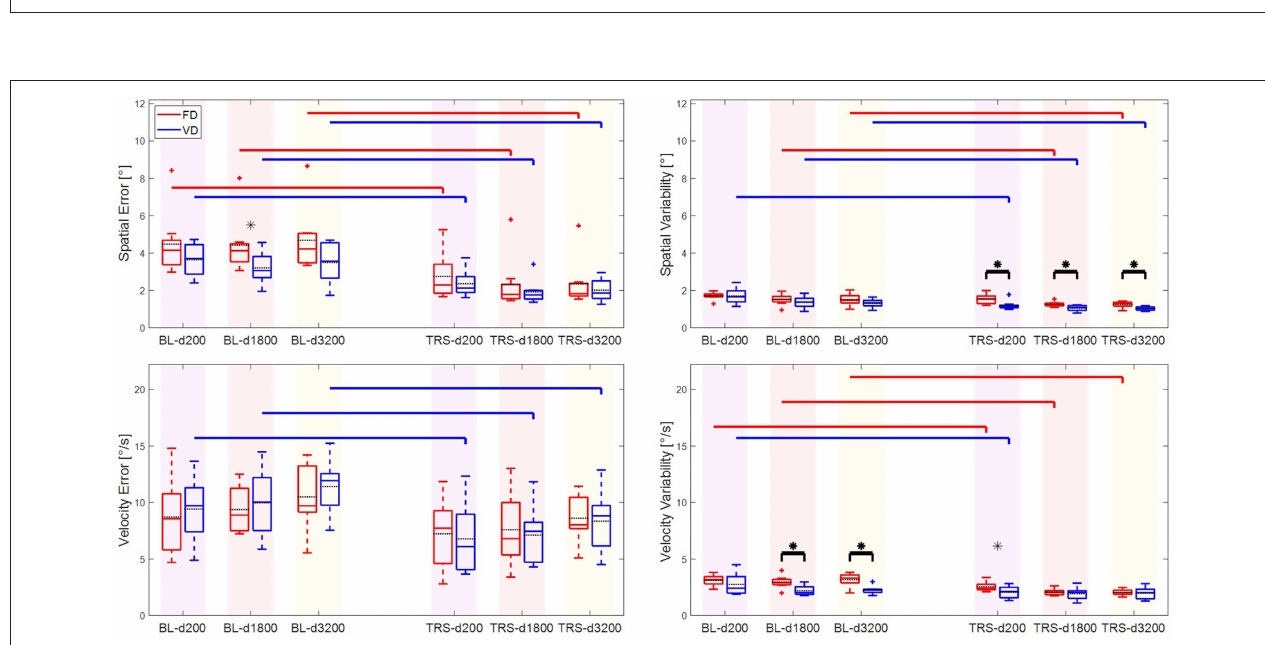
FIGURE 5 | Main outcome metrics vs. transfer condition tests for all subjects of the two groups: spatial error (Upper Left) , spatial variability (Upper Right) , velocity error (Lower Left) , and velocity variability (Lower Right) . Each density condition is displayed with a background color that corresponds to the water rendering color in visual scenario from Table 1